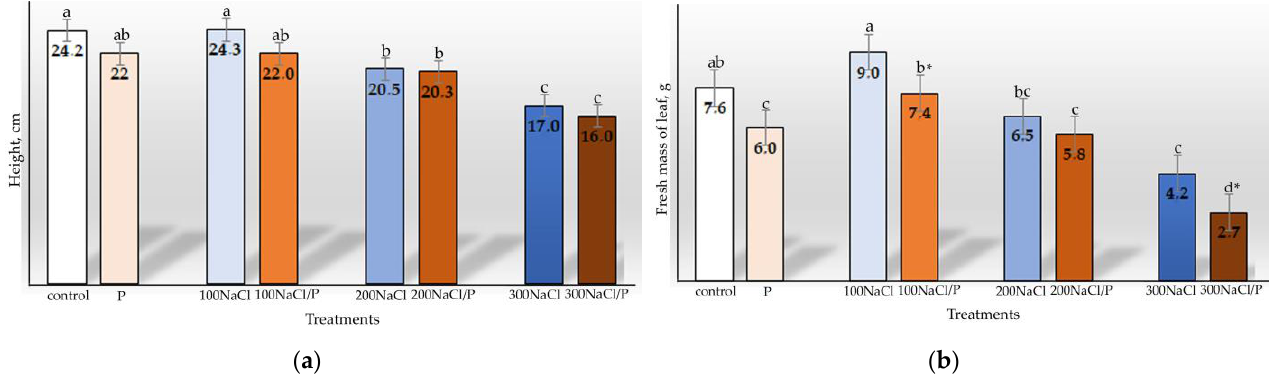
Figure 1. Dependence of growth parameters of young Chenopodium quinoa on stress conditions: ( a ) plant height; ( b ) leaf fresh weight. The values shown are means (± SD). Different letters above the bars indicate a significant difference within the chart (between different stress intensities), whereas * indicates a significant difference between the single component and the combined stress at p ≤ 0.05.